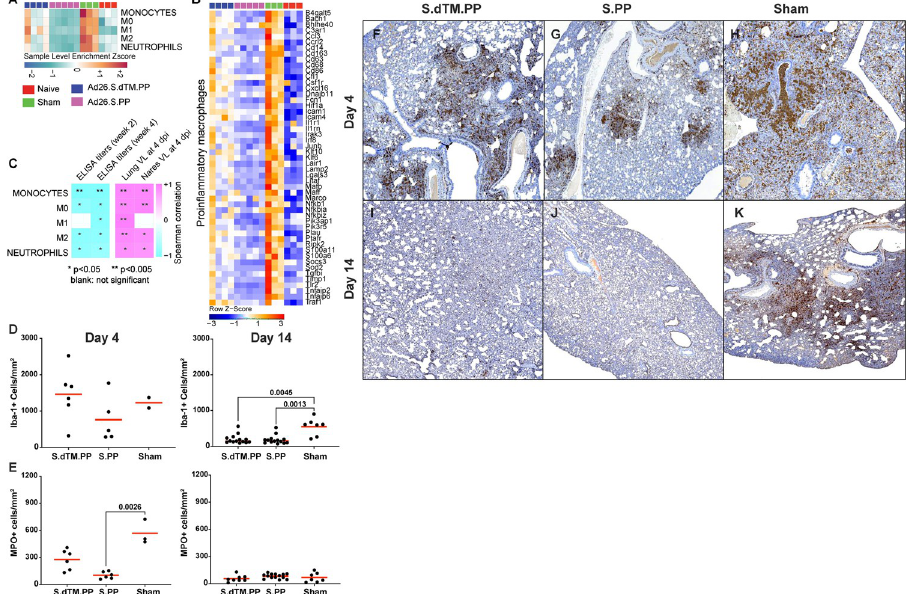
Fig 2. Pathways of macrophages and neutrophils were decreased in Ad26.COV2.S vaccinated compared to sham unvaccinated hamsters. (A) Sample-enrichment analysis (SLEA) of pathways of monocytes, macrophages M1 and M2 pathways, and neutrophils signaling at 4 dpi following SARS-CoV-2 challenge in vaccinated hamsters (shown in pink and blue colors), sham unvaccinated hamsters (shown in green) and in na ï ve control hamsters (shown in red). Heatmap presenting the SLEA z-score of each of these pathways. SLEA scores represent the mean expression of all significant genes within each pathway for each animal. An SLEA z-score greater than 0 corresponds to a pathway for which member genes are up-regulated, while an SLEA z-score inferior to 0 corresponds to a pathway with genes downregulated in that sample. Columns correspond to individual animals, and rows correspond to individual pathways scaled across all animals using the z-score R function. (B) Heatmaps of the normalized expression of the leading genes contributing to the enrichment of proinflammatory macrophages increased by SARS-CoV-2 in sham animals (in green) and decreased in Ad26 vaccinated hamsters (in pink and blue) at 4 dpi. (C ) Correlation matrix plot showing the Spearman correlations of the SLEA z-score of monocytes, macrophages (M0, M1and M2), and neutrophils pathways at 4 dpi with viral loads in hamster’s lung and nares at 4 dpi, and with neutralizing and binding antibody titers at weeks 2–4 post-vaccination in vaccinated hamsters. Negative correlations were shown in cyan, and positive correlations were shown in pink. ( D-K ) Myeloid inflammation resolves by 14 days following challenge in vaccinated hamsters. Immunohistochemistry (IHC) was performed on lung specimens from WA1/2020 challenged Syrian hamsters for macrophages (Iba-1) and neutrophils (myeloperoxidase, MPO) at 4 ( D, E left panels) and 14 days ( D, E right panels) following challenge and cells per unit area were calculated using quantitative image analysis. ( F-K ) Representative images of Iba-1 (IHC) from S.dTM.PP ( F, I ), S.PP ( G, J ), and sham ( H, K ) hamsters 4 days and 14 days following challenge. Kruskall-Wallis one-way ANOVA followed by Dunn’s multiple comparisons test. Red line =